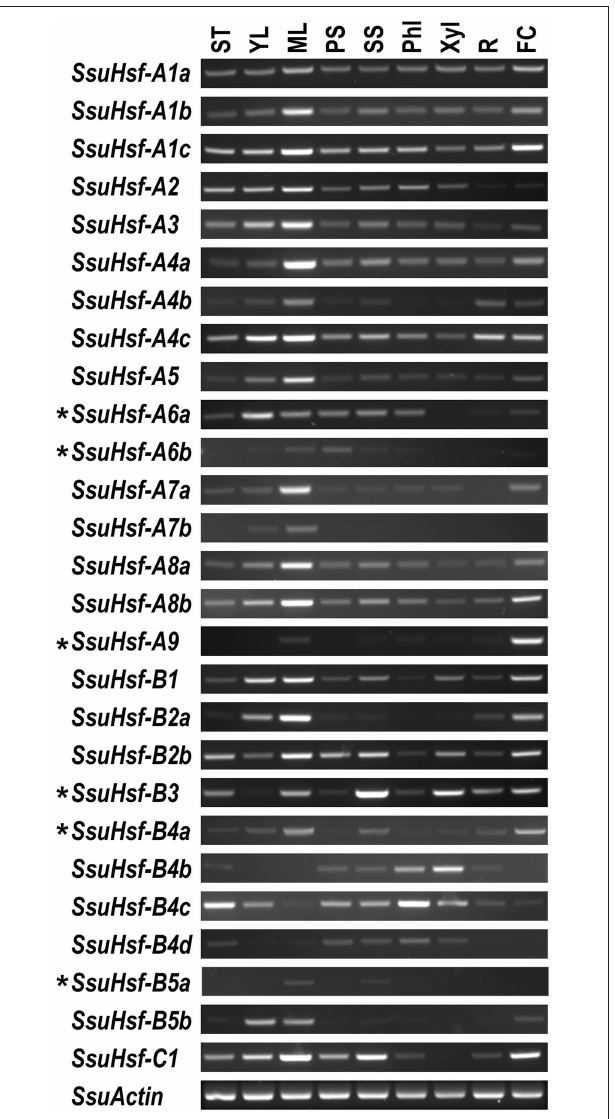
FIGURE 7 | Expression analyses of SsuHsfs in different tissues. The expression of 27 SsuHsfs in shoot tip (ST), young leaf (YL), mature leaf (ML), primary stem (PS), secondary stem (SS), phloem (Phl), xylem (Xyl), root (R), and female catkin (FC) from S. suchowensis . The amplification cycle used was 35 for six asterisk ( * ) labeled genes and 30 for all the other SsuHsfs and the SsuActin reference control. One experiment representative for three biological replicate experiments was shown in here. Primers used for RT-PCR are listed in Table S2